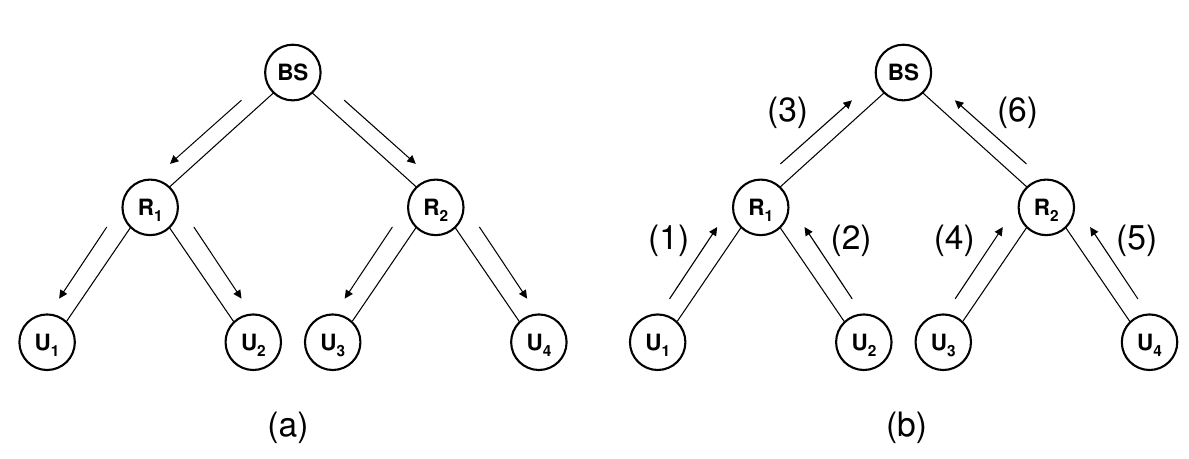
Figure 3. Message flow in a protocol